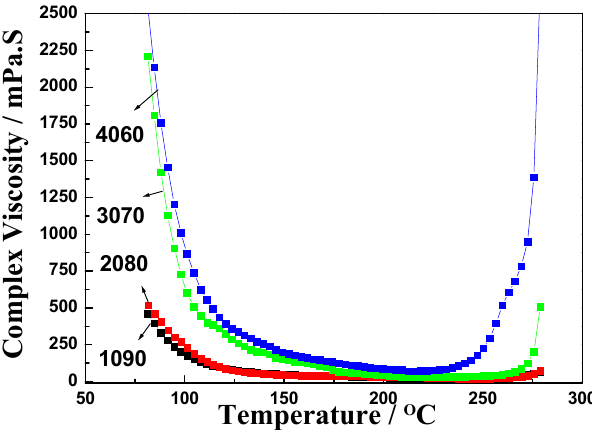
Figure 3. Complex viscosity of blends as a function of temperature. ( a ) 1090, ( b ) 2080, ( c ) 3070, and ( d ) ( d ) 4060.